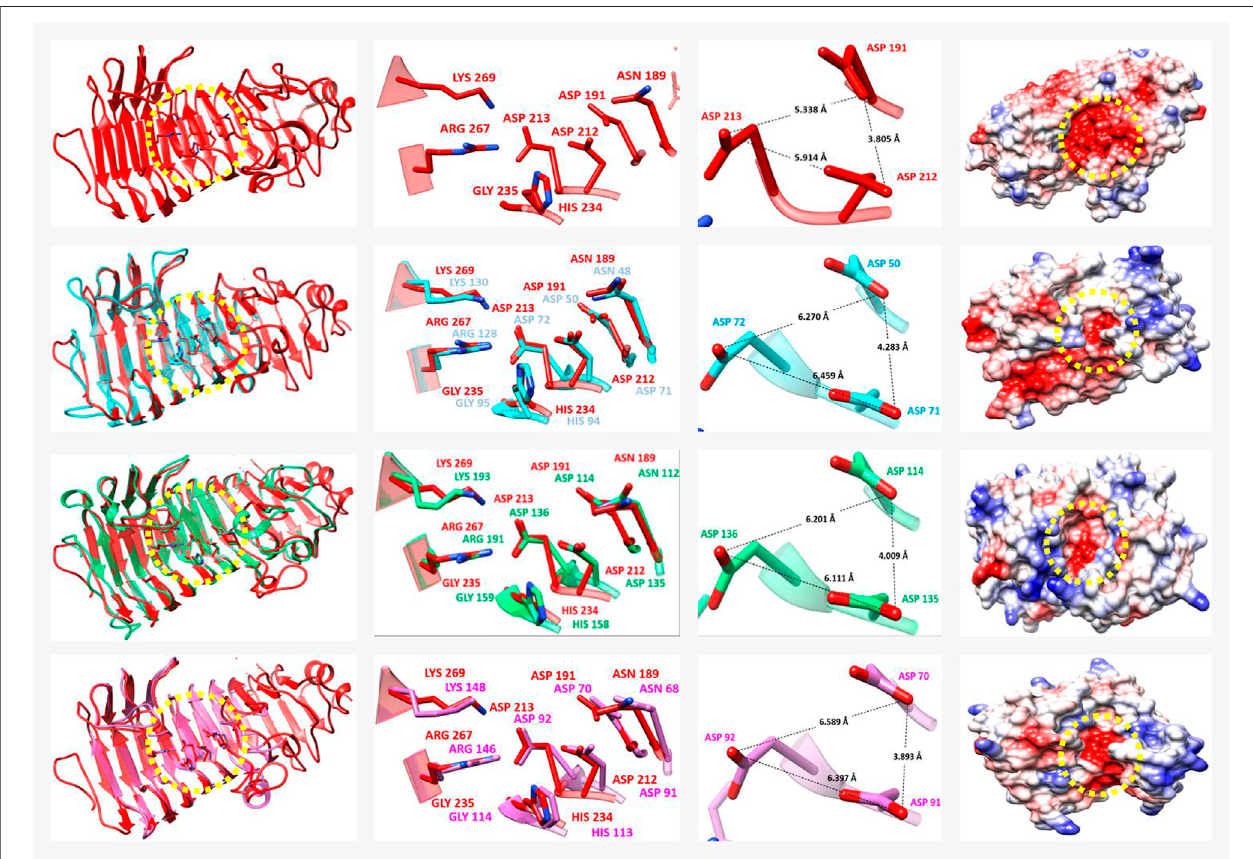
FIGURE 7 | 3D structure from some polygalacturonases (PG) members of GH28 family. From top to bottom, the PG from the phytopatogenic fungus Fusarium moniliforme (reference protein, PDB ID: 1HG8; Federici et al., 2001)) followed by the modelled PG of the mistletoe Psittacanthus schiedeanus . The PG from P. schiedeanus [UN045719, UN068437, and UN097465; cyan, green, and purple, respectively] were superimposed one by one with reference protein (red). From left to right (besides the 3D structures), a magni fi ed image with the highly conserved amino acid residues which form the cleft of the active site, is shown. This image is followed by others with the estimated distance between the catalytic residues (three aspartic acid (Asp) residues) and fi nally, an electrostatic surface charge representation. The yellow dotted circles show the active site with a relatively low presence of positive charges. After alignment and the superimposing of the 3D modelled structures, the equivalent position of every amino acid residue into the active site is shown. PG 3D proteins models from P. schiedeanus were constructed in silico based on the homology to cited proteins and their solved crystal structure.